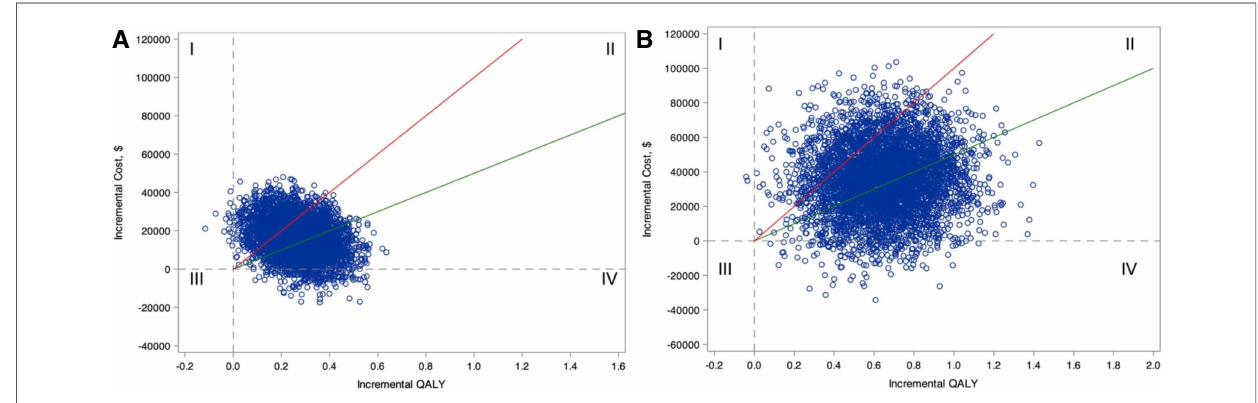
FIGURE 2 Incremental cost-effectiveness plane for comparing ablation with drug therapy for the entire CABANA cohort (catheter ablation vs. Antiarrhythmic Drug Therapy for Atrial Fibrillation; N =2204; A ) and the heart failure subgroup with New York Heart Association class ≥ II symptoms ( n =778; B ). Estimates of incremental costs and quality-adjusted life-years (QALYs) are shown (1 blue circle for each of 5,000 bootstrap samples). Quadrant I represents scenarios where ablation is more costly and less effective, Quadrant II represents scenarios where ablation is more costly and effective, Quadrant III represents scenarios where ablation is less costly and less effective, and Quadrant IV represents scenarios where ablation is less costly and more effective. The willingness-to-pay thresholds of $50,000 and $100,000 per QALY gained are represented as the slope of the green and red lines, respectively. Scenarios that fall below these willingness-to-pay-thresholds are considered economically attractive. (Reproduced from Circulation. 2022;146:535 – 547 with